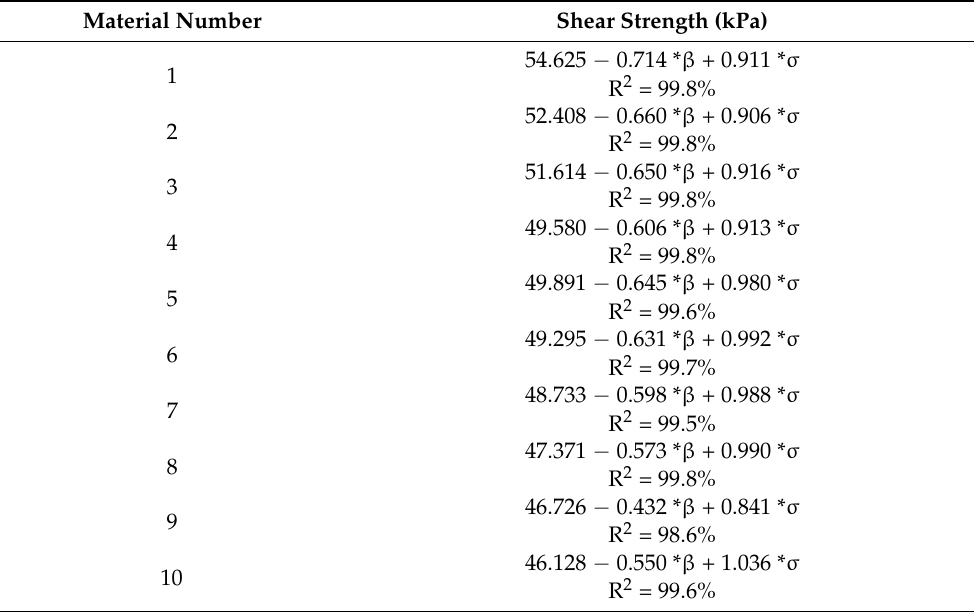
Table 7. Correlations in the case of clay—unsaturated seismic